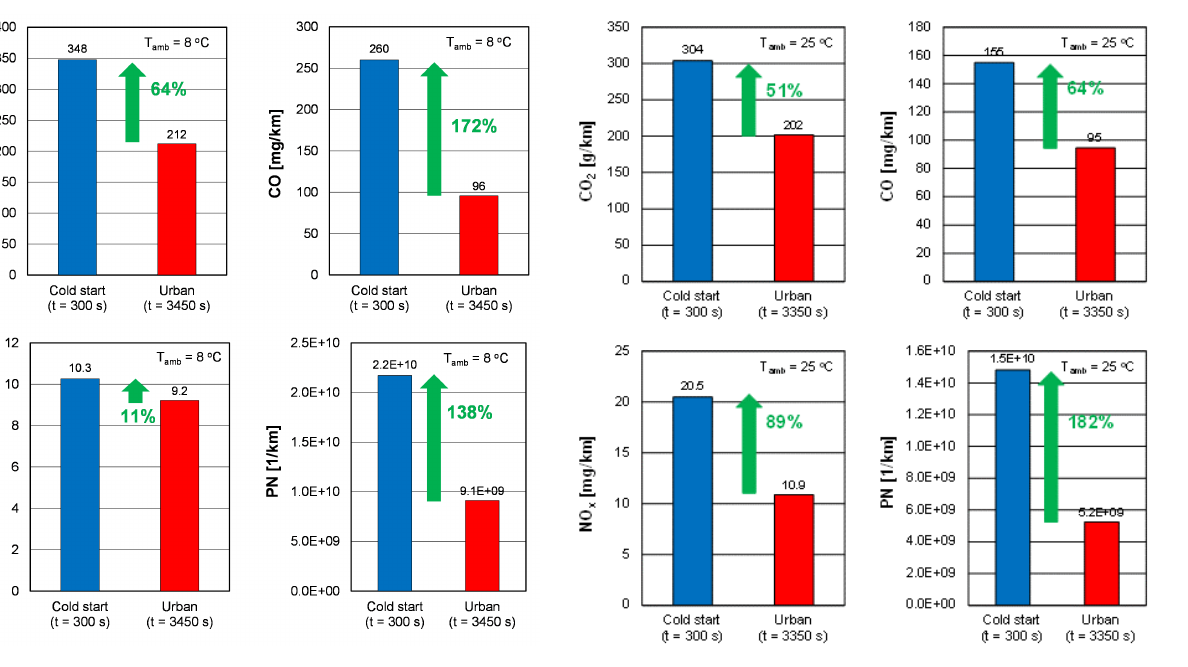
cold start (25 ∘ C) an increased concentration of nitrogen oxides (up to 300–400 ppm) is observed during the first 50 seconds after the engine start. At this point in time (50 s), the concentration of nitrogen oxides during a cold start at 8 ∘ C is several times higher (80 ppm) than at 25 ∘ C (10 ppm). The time it takes the measured concentration values of this compound to reach values below 10 ppm is similar and equals about 100 s. Regarding the number of particu-